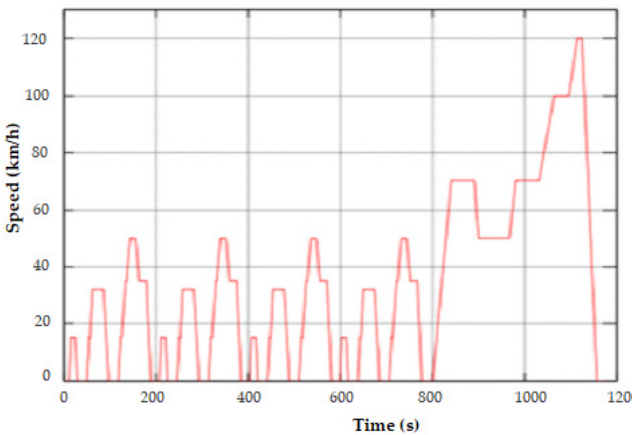
Figure 9. Speed profile of the New European Driving Cycle versus time. For the conversion from vehicle speed to battery current, the method consists of esti- mating the power decrease/increase for a step of time, giving the increase/decrease in ki- netic energy. The power variation due to the vehicle acceleration/deceleration is a balance of the vehicle weight force, the rolling resistance, the drag resistance, and also the incline of the road. By dividing this power balance by the voltage, the equivalent current intensity is then obtained. For cell characterization, the kinetics energy due to the speed is directly converted to power versus time, and then to current evolution versus time; see [34] for more details. The translation of the NEDC speed chart into current steps is shown in Figure 10; it is possible to observe an altering of the current steps and the resting periods, allowing relaxation of the cell chemistry. Eight successive NEDC cycles are applied to a fully charged cell, and the corresponding SOC evolution is represented in Figure 11. The SOC ranges from 1 at the beginning to 0.08 at the end of the 8 NEDC cycles; it covers almost the whole SOC range. Figure 10. Current profile equivalent to a NEDC cycle.